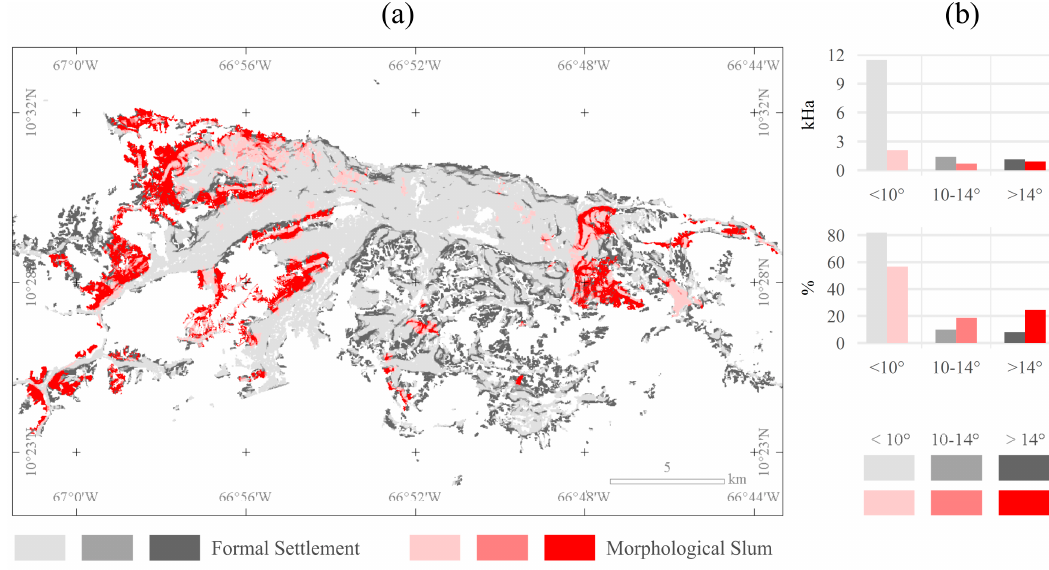
Figure 9. Location of the settlement types and their calculated slope inclination (a) and absolute and percentage shares of settlement types in areas with different slope inclinations in Caracas (b).